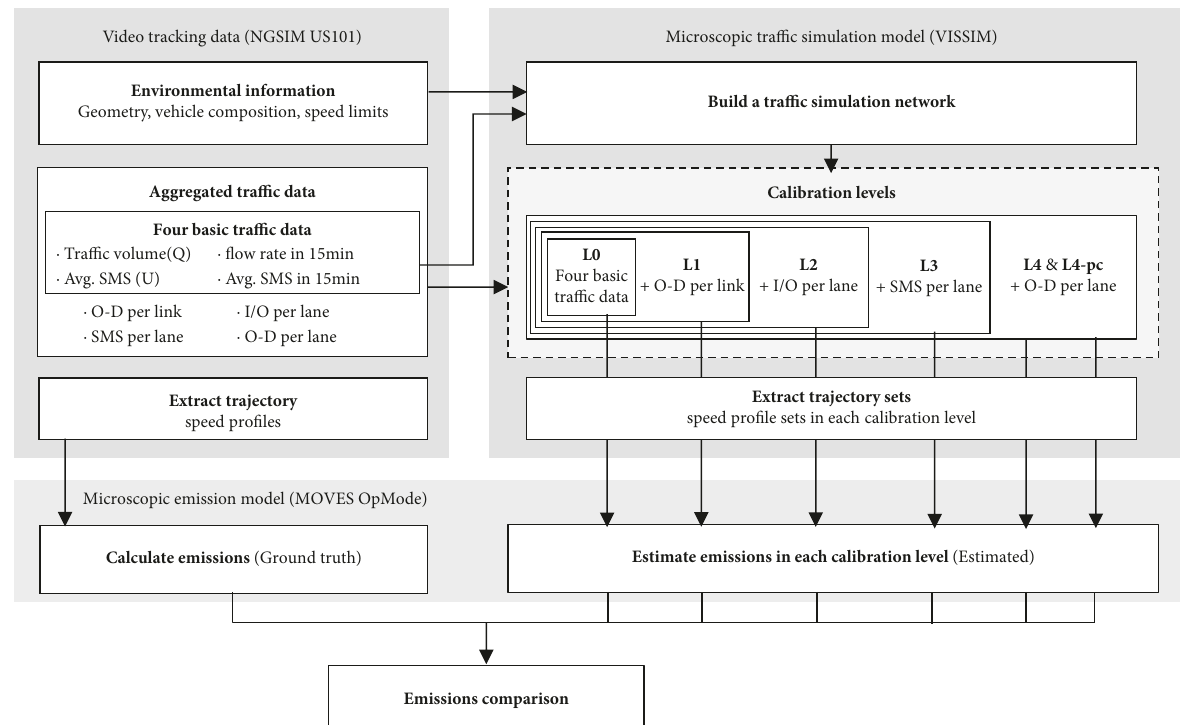
Figure 1: Overall framework of study to evaluate the effects of traffic simulation calibration level on micro-scale vehicle emissions